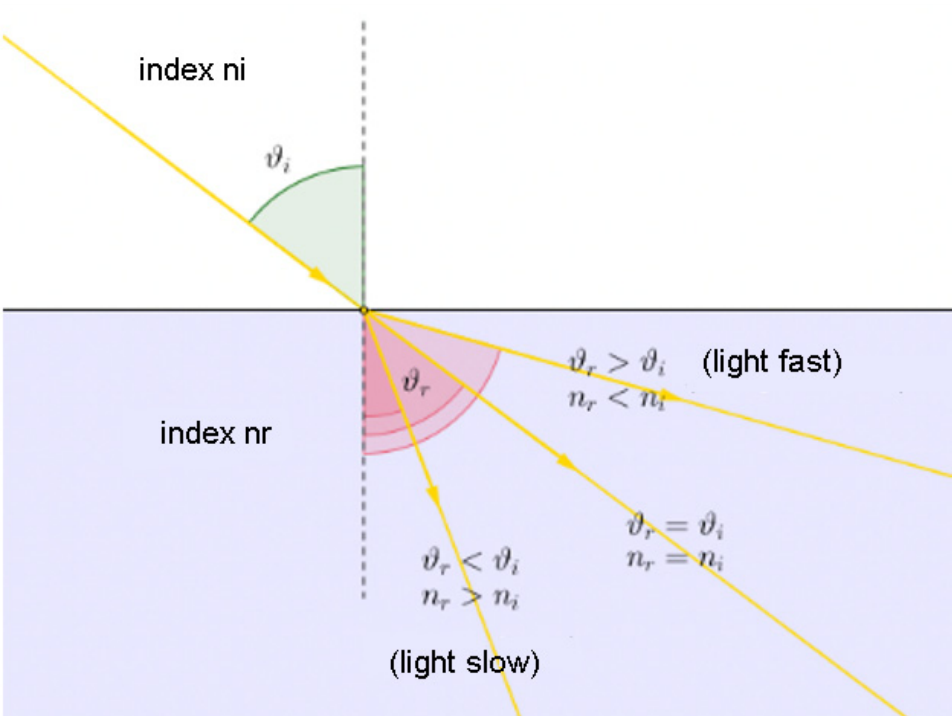
Figure 4. Effect of the phenomenon of refraction of solar radiation [45].